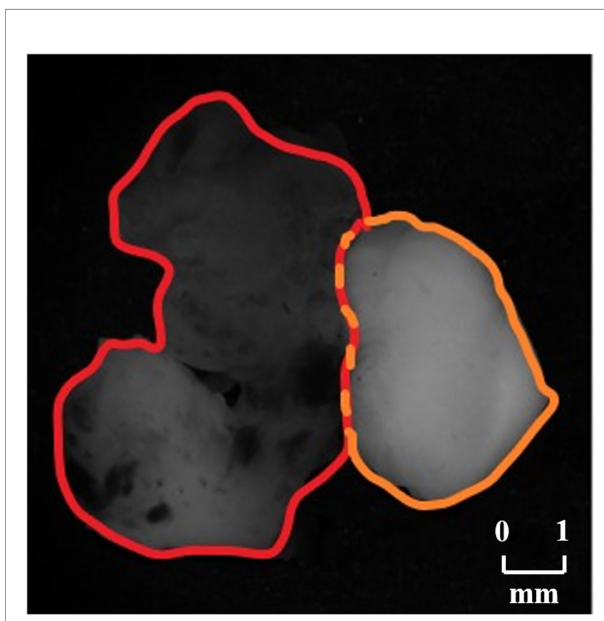
FIGURE 2 | Grayscale images of the GBM sample with non-GBM brain tissue, where the GBM region is marked with red boundary delineated and the non-GBM region is marked with orange boundary